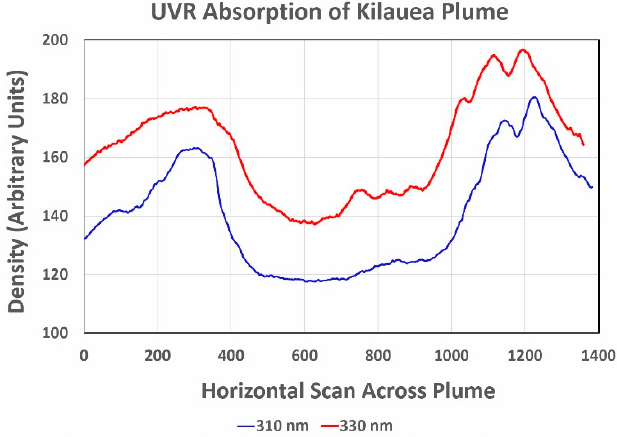
Figure 20. Densitometry scans across the Kilauea plume in the 310- and 330-nm images in Figure 19 show the enhanced absorption by SO 2 at 310 nm.